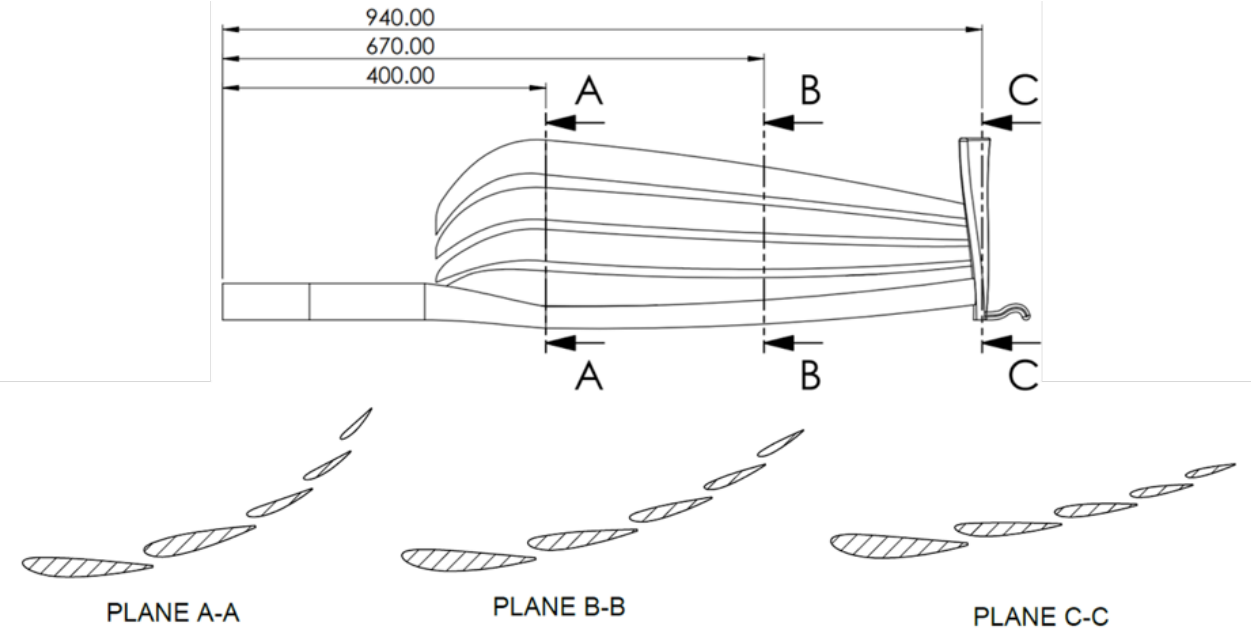
Figure 1. View and location of the three different planes where the cross-sections for the front wing shape design optimisation have been